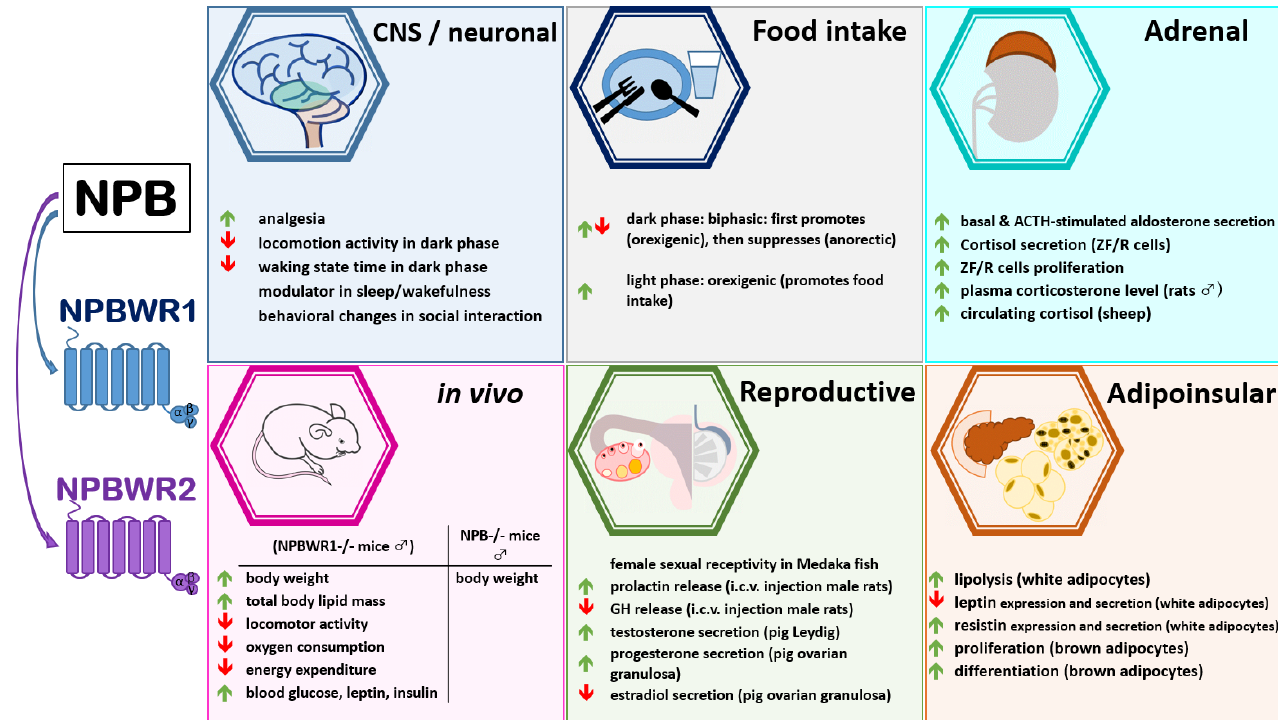
Figure 1. Biological effects of neuropeptide B.